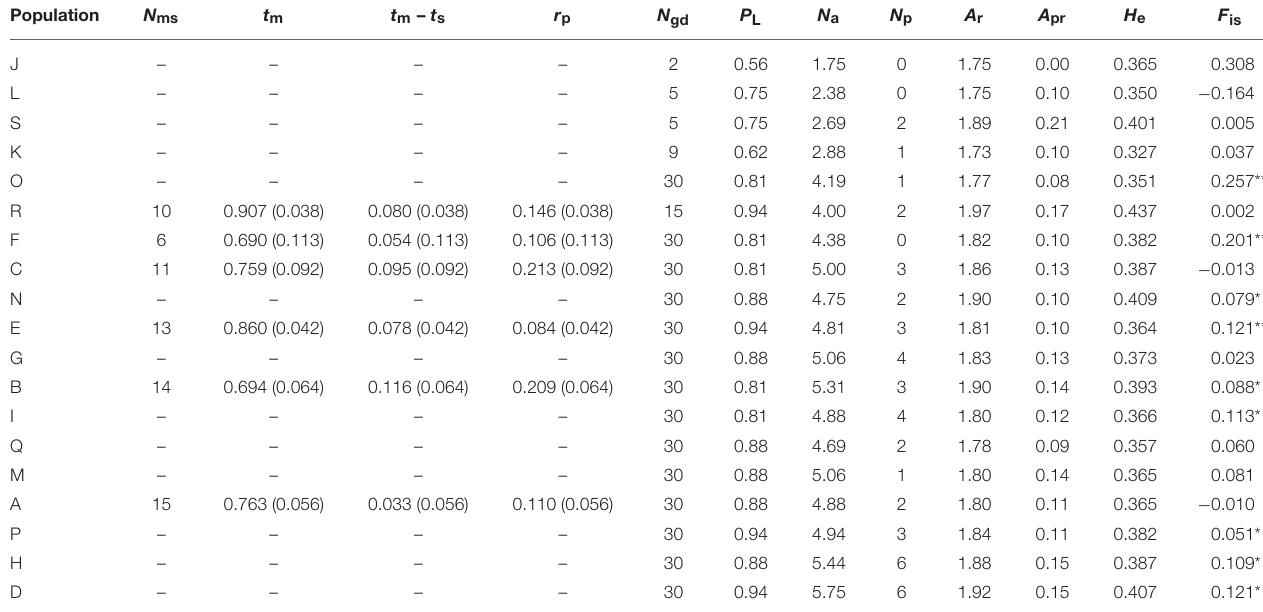
TABLE 7 | Mating system and genetic diversity parameters estimated for Eucalyptus wandoo plants from up to 19 populations.